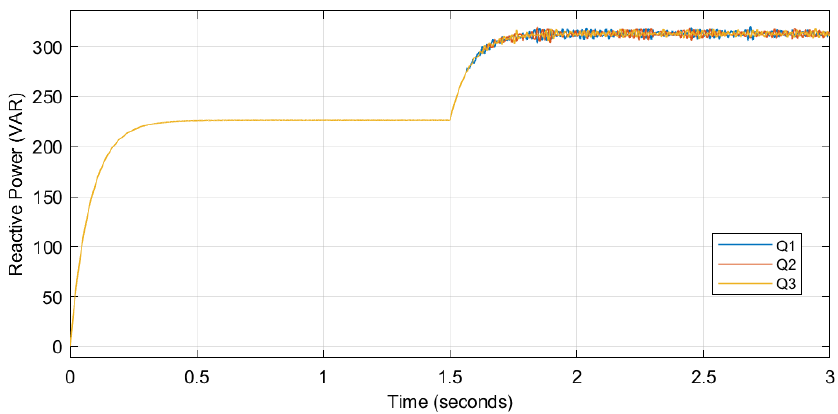
Figure 13. Reactive power output of the droop controller with typical virtual impedance.